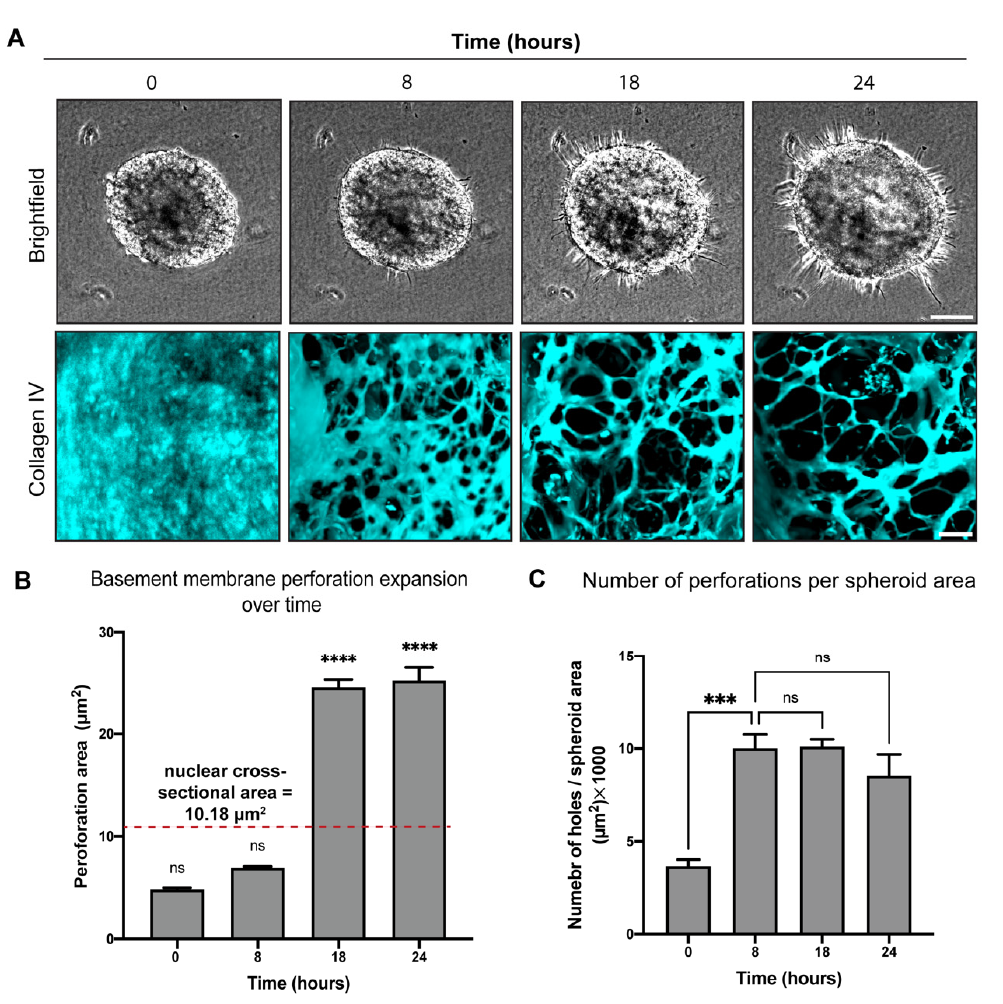
Figure 3. Basement membrane perforation over time. ( A ) Brightfield images of a spheroid from a time-lapse video spanning 24 h ( upper images ) and basement membrane perforations from the same time points depicted by collagen IV staining ( lower images ). ( B ) Quantification of the average areas of individual basement membrane holes (±SEM) at each of the corresponding time points ( lower images ). Dashed line on the graph indicates the mean nuclear cross-sectional area of MDA- MB-231BO cancer cells. ( C ) Quantification of the number of holes per spheroid area. **** p < 0.0001 *** p < 0.0003.These graphs are based on pooled data from at least 3 independent experiments each including at least 3 spheroids per experiment, all of which showed similar results. Scale bars: ( A ), top row , 100 µm; ( A ), bottom row , 10 µm.